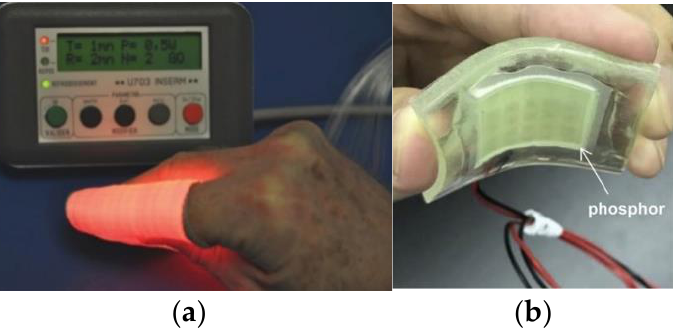
Figure 5. ( a ) Textile light diffuser applied on a finger-curved surface (image adapted from [112]). ( b ) Flexible LED unit designed for multi-wavelength excitation of 5-ALA (image adapted from [114]). For I-PDT, delivery devices include diffusers of different geometries such as spherical, balloons, and cylindrical for wider illumination areas [8,116]. Their sizes range